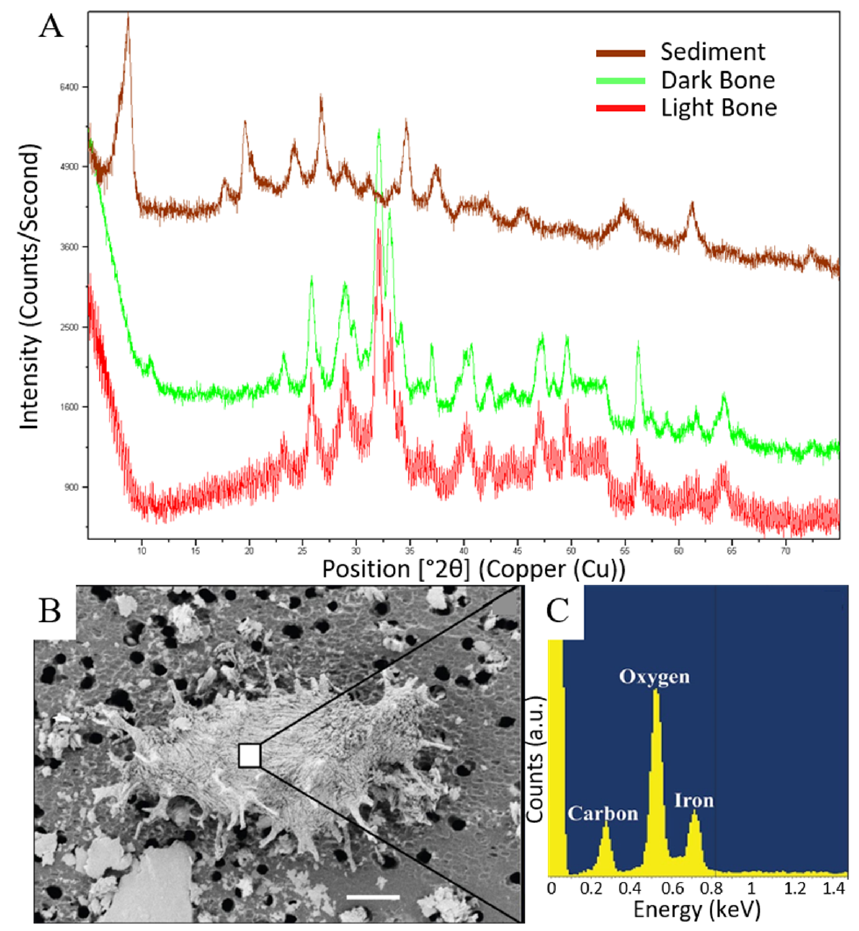
Figure 3. Mineralogical analysis of sediment, dark bone, and light bone samples from EFP and SEM- EDS of a structure morphologically consistent with an osteocyte from RU-EFP-00006-11. ( A ) Diffractogram of XRD results showing distinct differences between the sediment and fossils, which were identified as glauconite and fluorapatite, respectively; ( B ) SEM micrograph of a structure morphologically consistent with an osteocyte; ( C ) EDS spectrum from center of osteocyte (square area) in ( B ). The large peak surrounding 0 keV is an artifact of the very low count rates from the osteocyte. Scale bar 4 µm in ( B) .